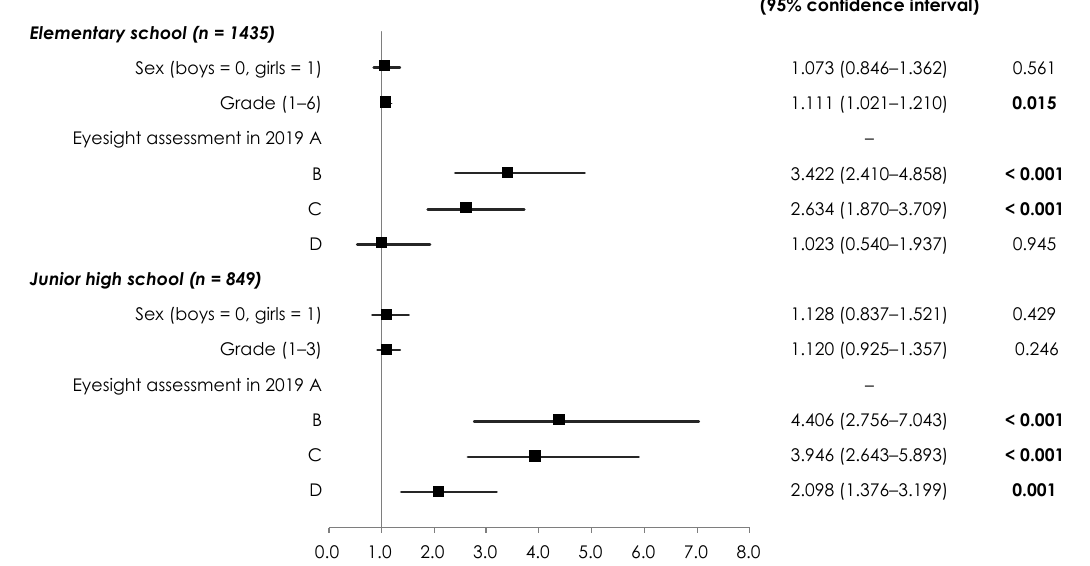
Figure 2. Relationship between eyesight in 2019 and the changes in eyesight from 2019 to 2020. The dependent variable was the change in eyesight from 2019 to 2020 (0 = no change or positive change, 1 = negative change), and the independent variable was the eyesight in 2019. Measures of associations are displayed as odds ratios (black squares) and 95% confidence intervals (horizontal spikes). Significant p values are shown in bold.